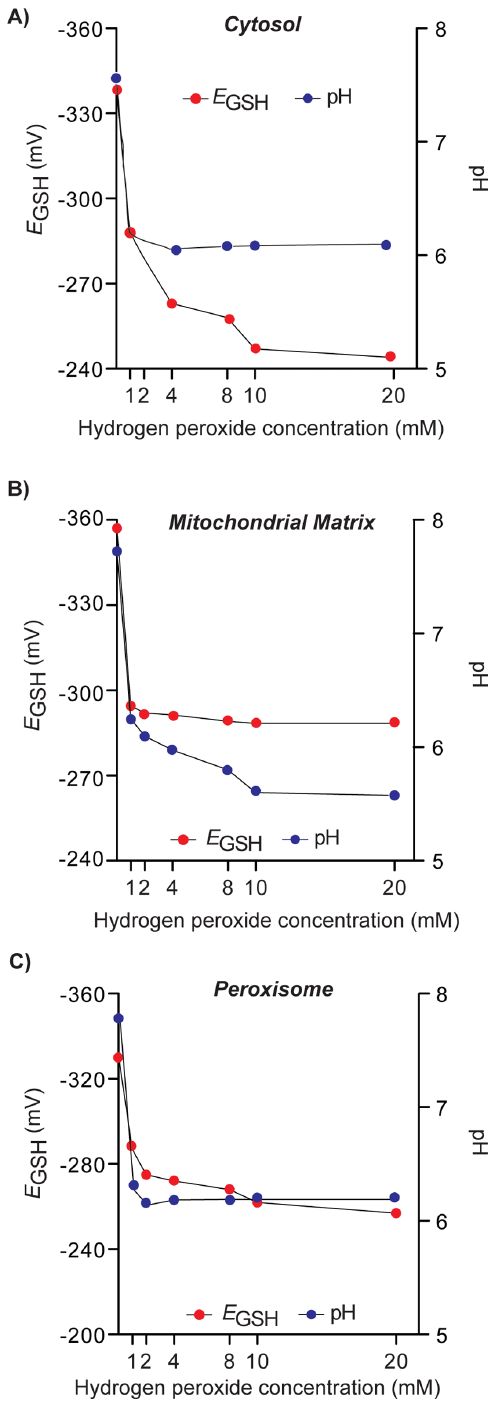
Figure 4. Effect of hydrogen peroxide on compartmental E GSH and pH. A-C) Cells were pregrown in SC URA (48 h; 30 u C; 600 rpm), inoculated in SC URA (A 600 =0.001) and grown (25 u C; 600 rpm) until exponential phase (A 600 = , 0.5). Cells were then treated with various doses of hydrogen peroxide for 30 min and pH and redox environment analyzed. (A cytosolic pH and E GSH , B) mitochondrial matrix pH and E GSH , C) peroxisomal pH and E GSH . 10,000 cells were counted for each sample. Each experiment was conducted in triplicate with error bars represent- ing the standard deviation of three experiments. Error bars may be difficult to visualise as the errors are in the , 5 mV